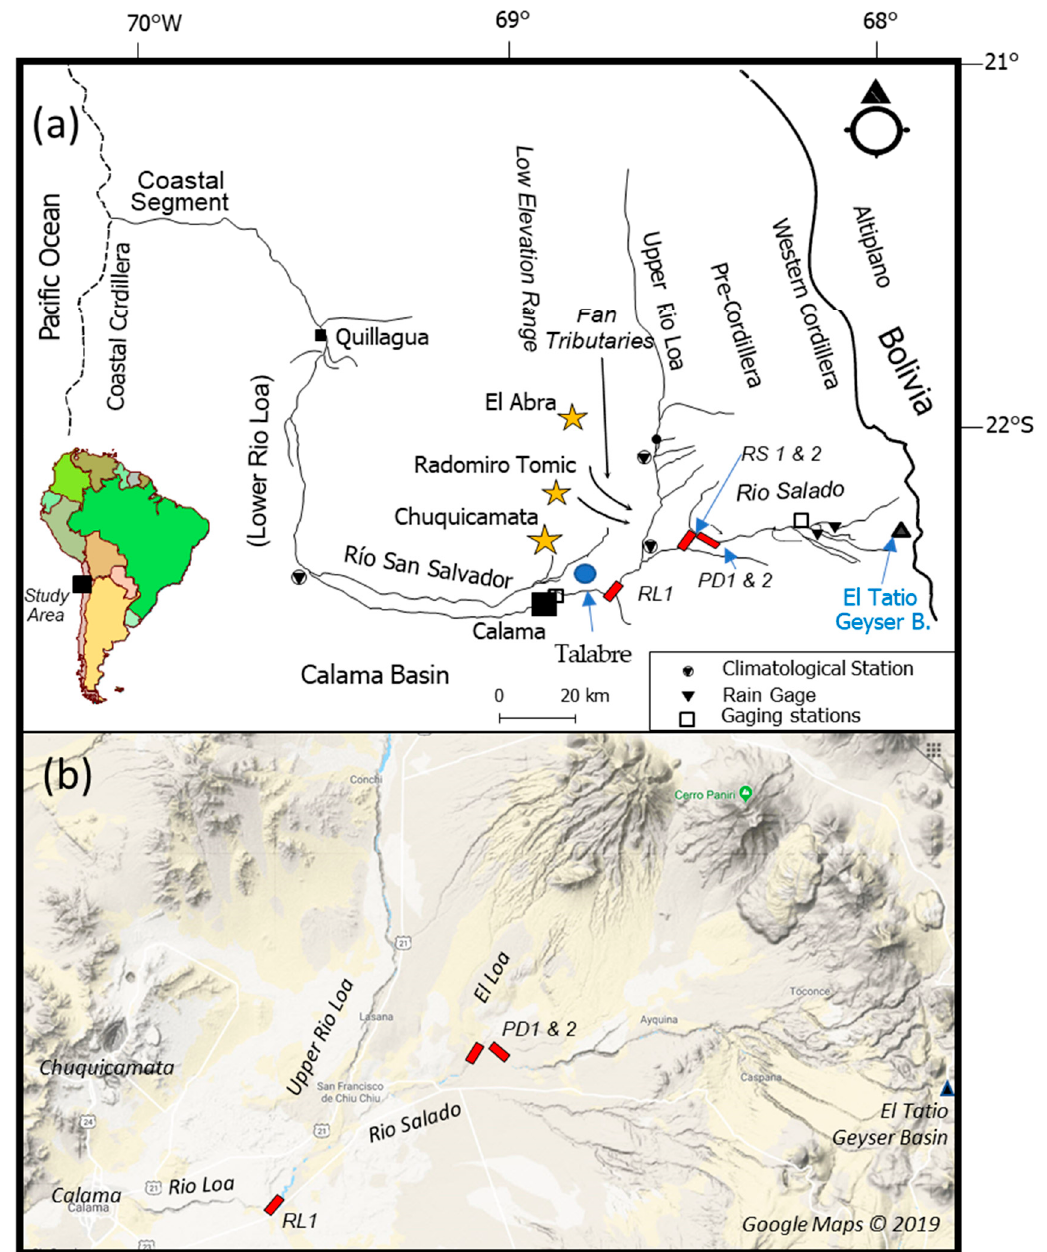
Figure 1. ( a ) Location map of Rio Loa Basin, northern Chile; ( b ) schematic diagram illustrating physical and geochemical processes involved in trace metal dispersal.